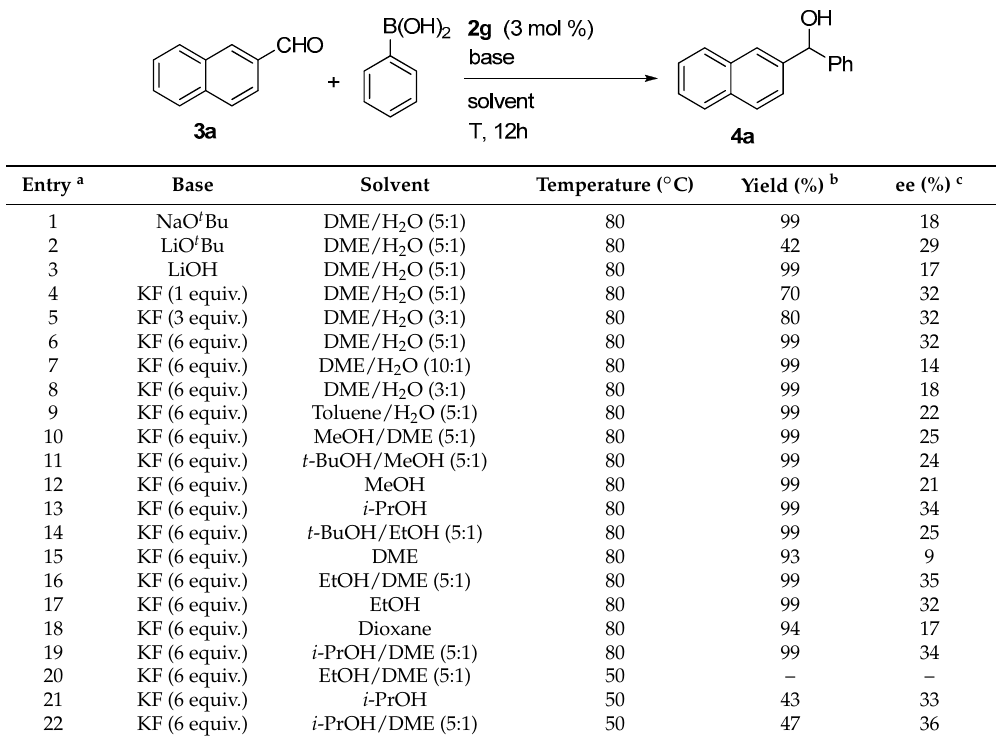
Table 2. Optimization of the reaction conditions.